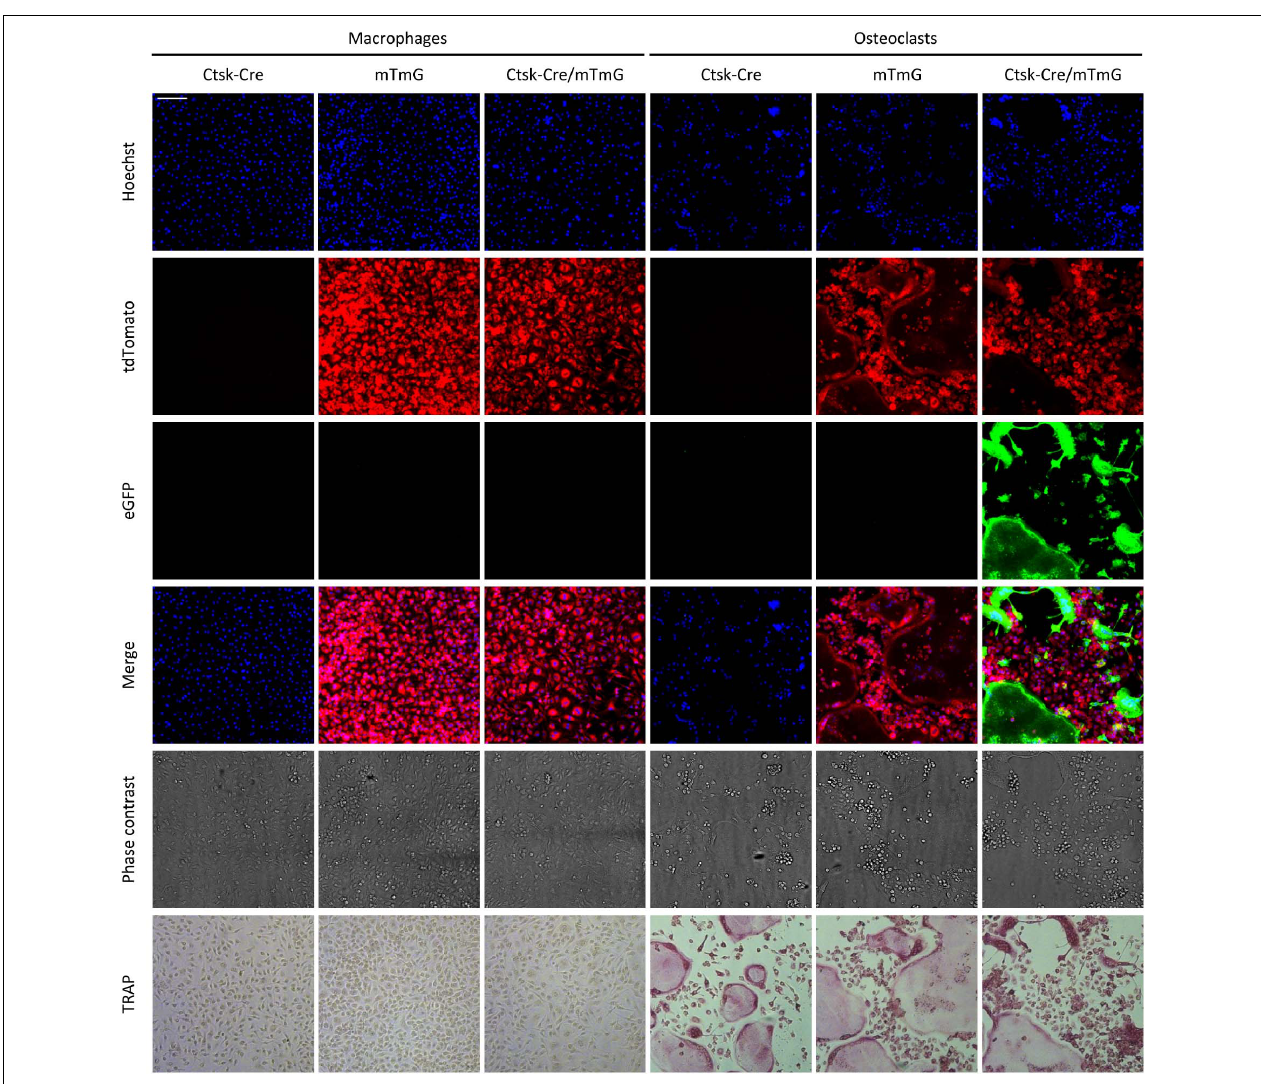
FIGURE 2 | Fluorescence and brightfield images of the FRAMCO1.1 assay. Representative images of macrophage and osteoclast cultures taken on Day 5 of differentiation (where Day 0 is defined as the time RANKL is first added to osteoclast cultures). Nuclei were stained with Hoechst dye. The first three rows show images from the blue, red and green fluorescence channels, supposedly corresponding to signals from the indicated fluorophores. The cells were fixed and stained for TRAP after taking fluorescence and phase contrast images. Each column shows images from the same field of view. The scale bar corresponds to 100 µ m and applies to all images. Images are representative of 8–10 independent